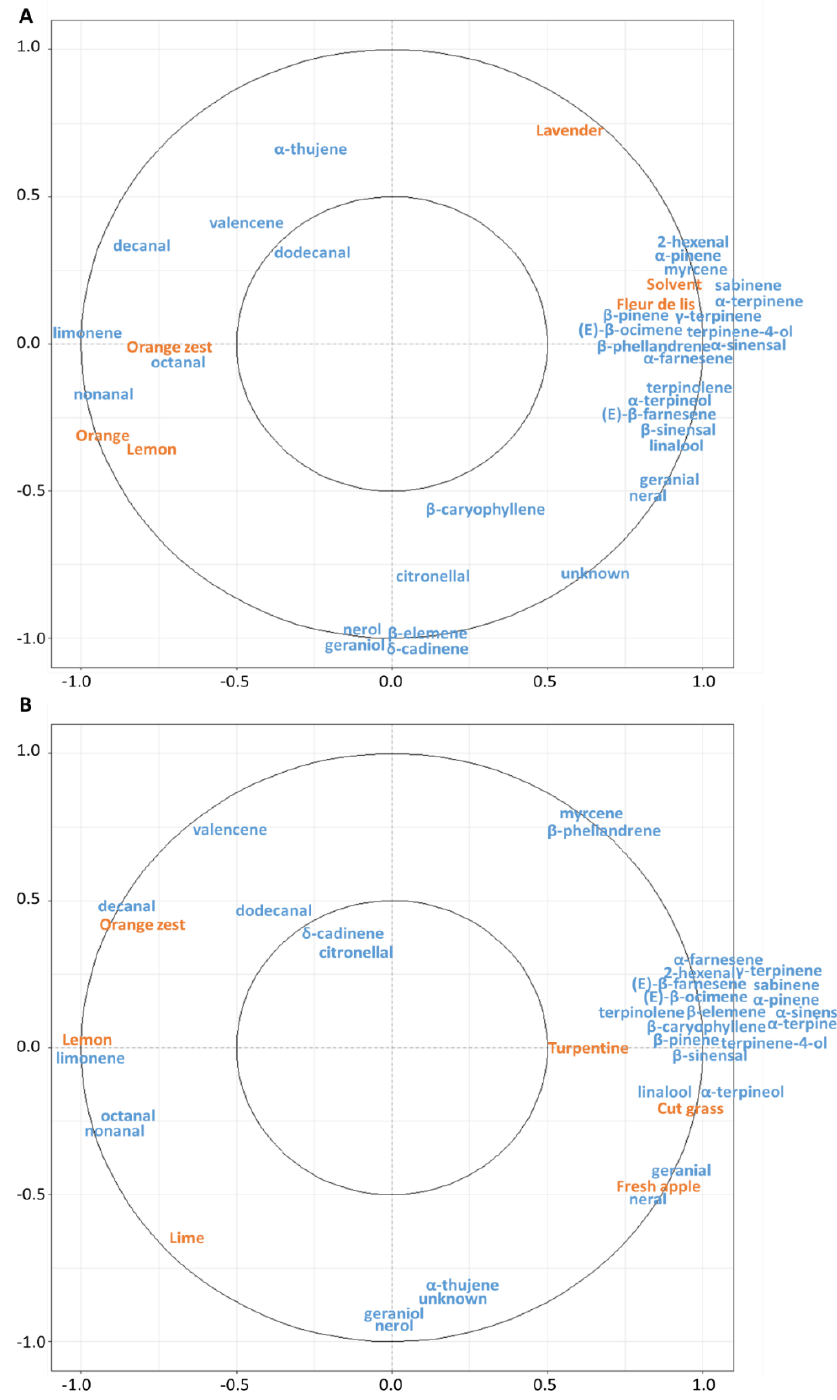
Figure 7. Correlation circles between PEO compounds and aromatic descriptors using partial least squares regression. Compounds are represented in blue, and aromatic descriptors are represented in orange. The inner circle corresponds to a correlation of (±) 0.5, and the outer circle corresponds to (±) 1. ( A ) “Cara Cara Navel” and ( B ) “Madame Vinous”.